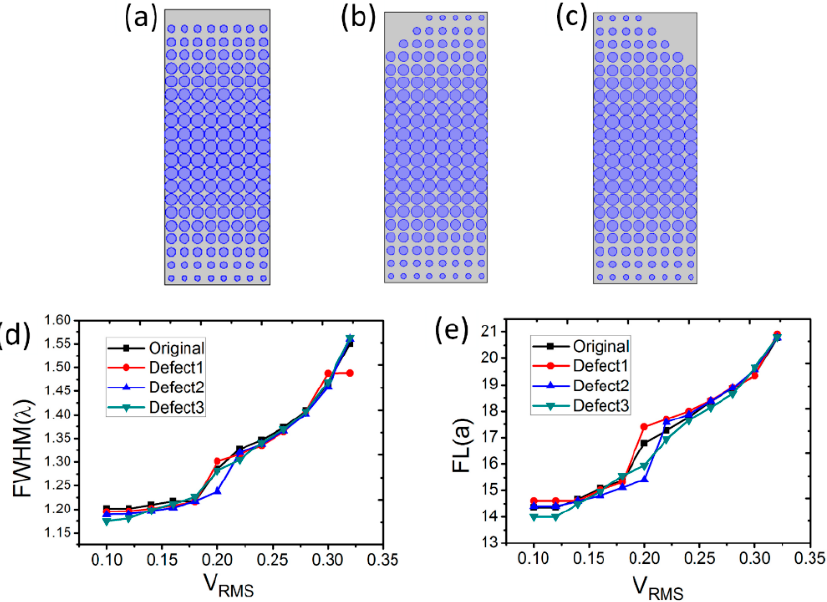
Figure 6. Schematic diagram of defects for ( a ) lack of a row of rod on the edge ( b ) lacking of a corner at the front ( c ) lacking of a corner at the back; ( d ) The FWHM and ( e ) the FL curves with the RMS voltage variation under different defects.